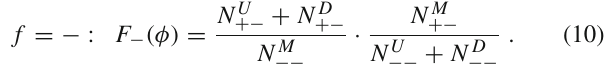
Fig. 6 The modulation amplitudes a of the h + and h − azimuthal asymmetries as the function of x , z and p h 2002–2006 data on the muon SIDIS off longitudinally polarised deuterons. Only uncertainties of fits are